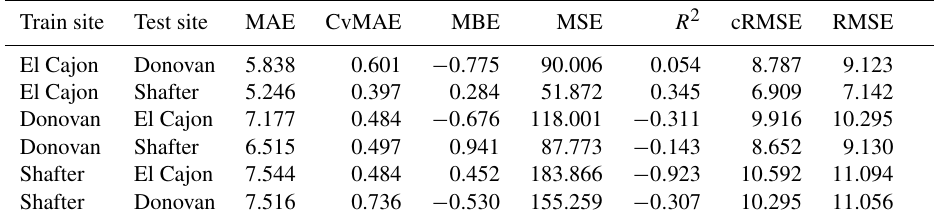
Table D1. Test results for split-NN Level 1, size 3 (NO 2 ).